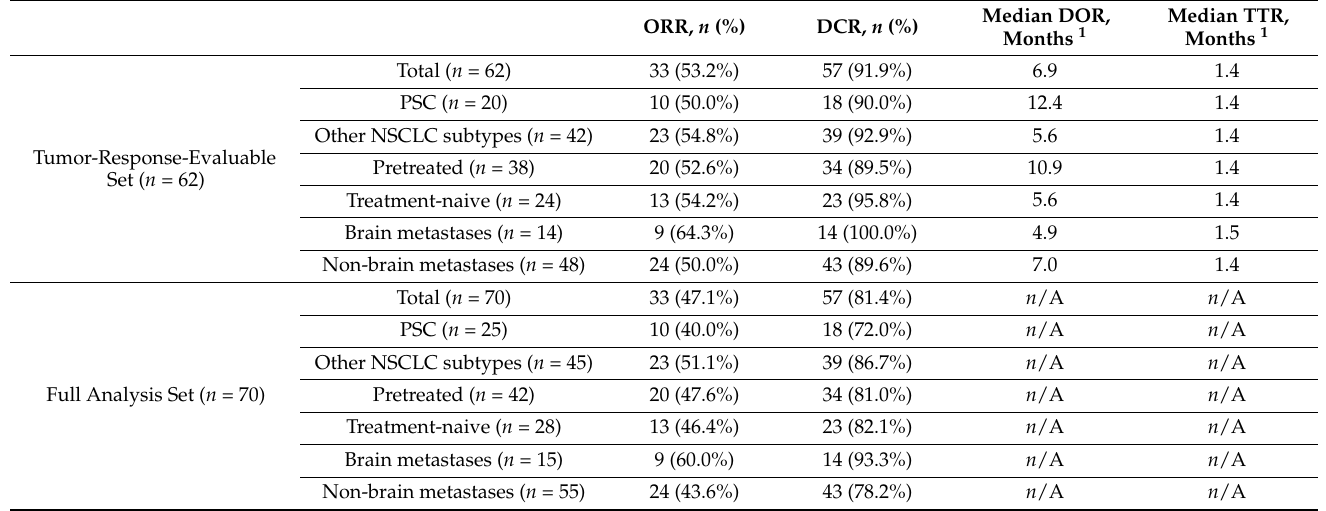
Table 3. Investigator-Assessed Responses in the Tumor-Response-Evaluable Set and the Full Analysis Set of Phase II Trial Conducted in China